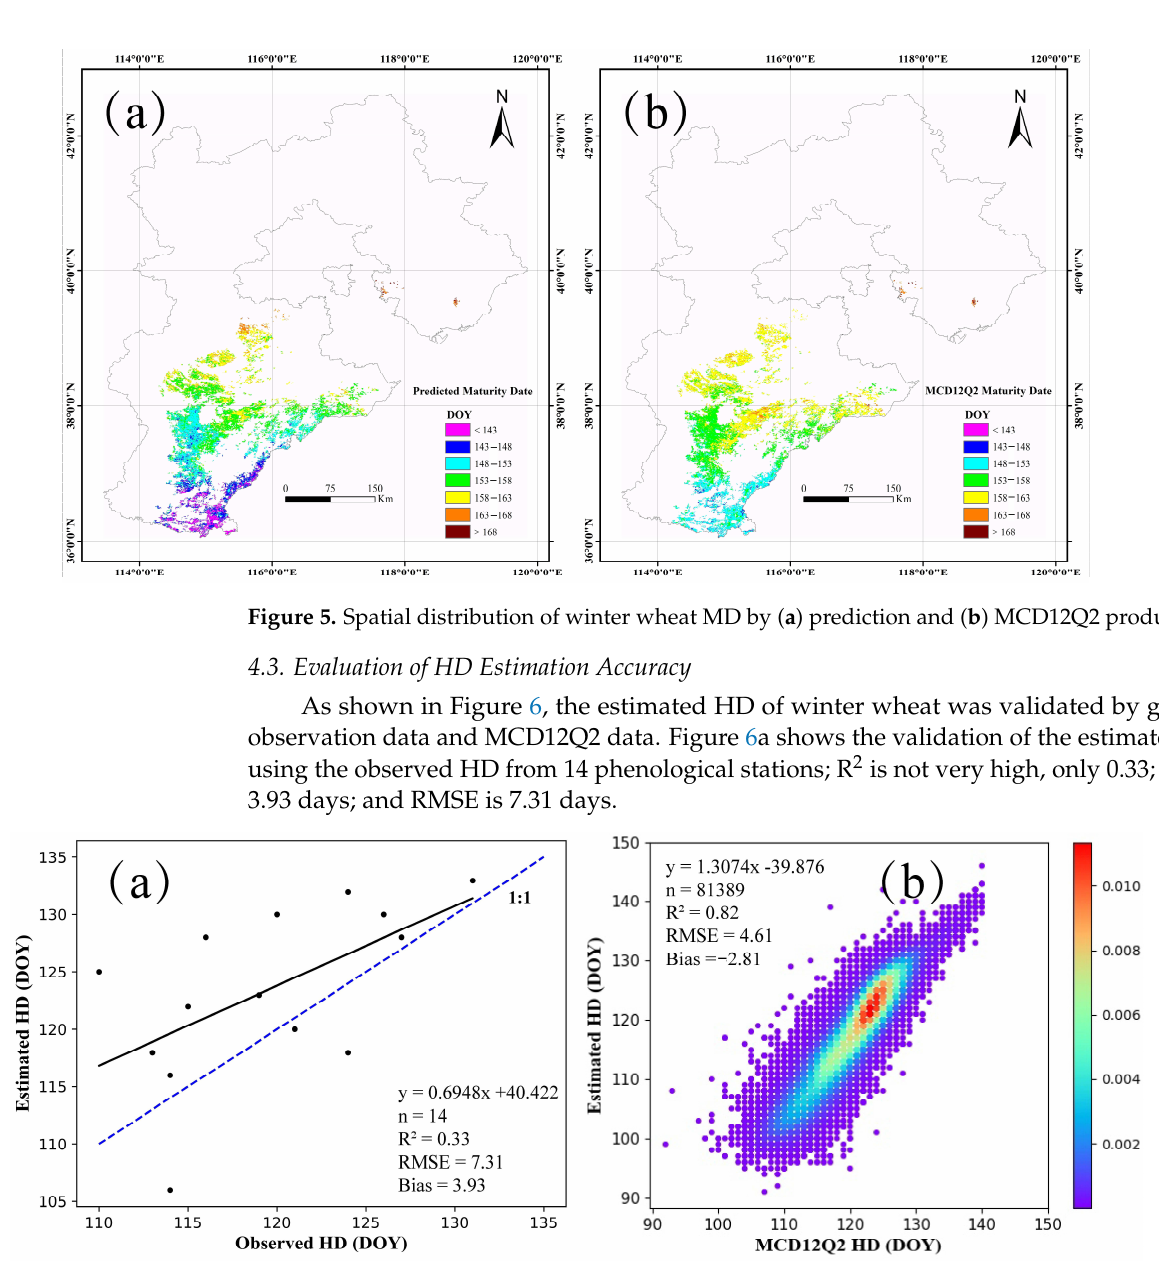
Figure 6. The validation of estimated HD of winter wheat by ( a ) ground observed data and ( b ) MCD12Q2 data.